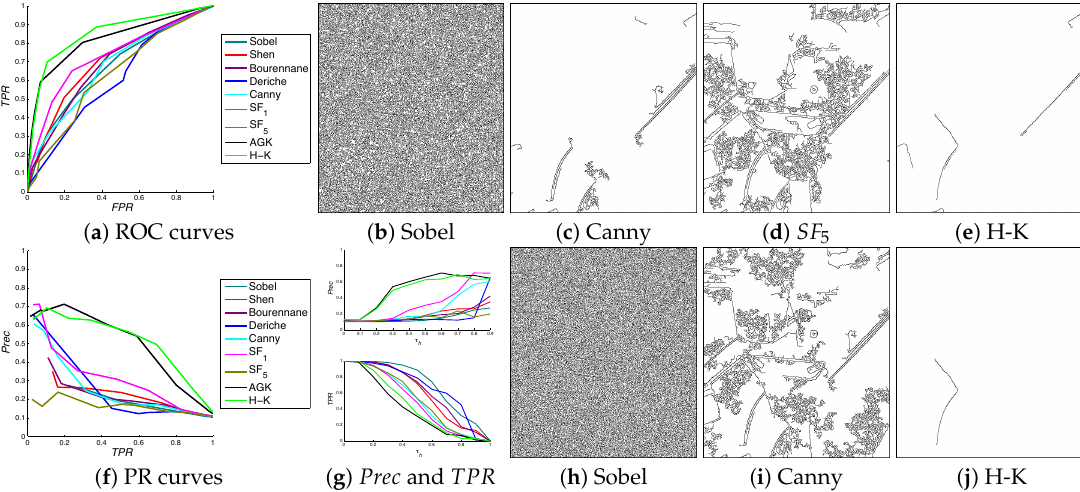
Figure 4. Receiver Operating Characteristic (ROC) and Precision–Recall (PR) curves for several edge detectors. Images in ( b – e ) and ( h – j ) represent the best segmentation for each indicated detector tied to ROC curves and PR curves, respectively. The ground truth image (parkingmeter) is available in Figure 16 and the original image in Figure 17 (Peak Signal to Noise Ratio: PSNR = 14 dB). Derived from TPR and FPR , the three measures Φ , χ 2 and F α (detailed in Table 2) are frequently used. The complement of these measures translates a value close to 0 as a good